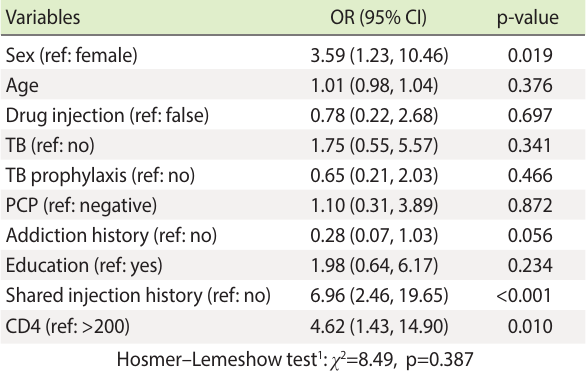
Table 6. Distribution of co-colonization with different yeast